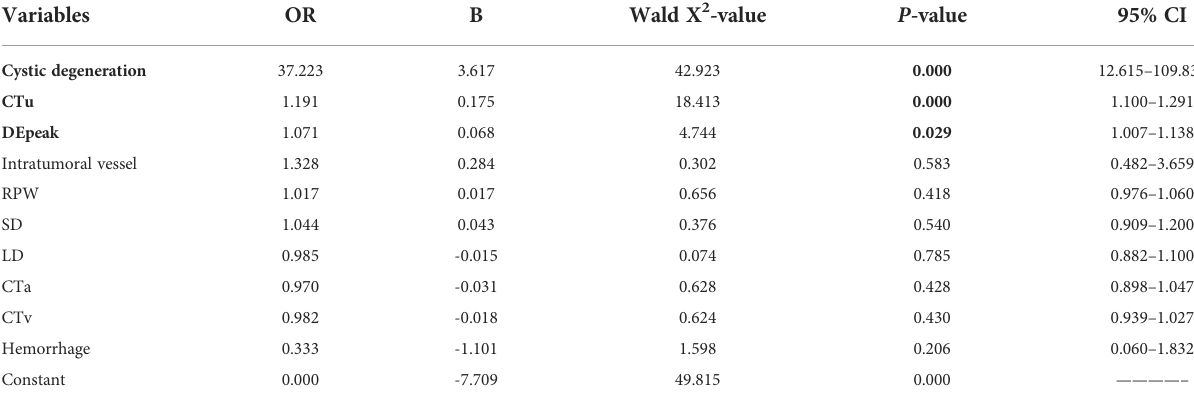
TABLE 5 Binary regression analysis for identifying adrenal PCCs in all subjects (groups 1, 2, and 3) on the training set. Variables